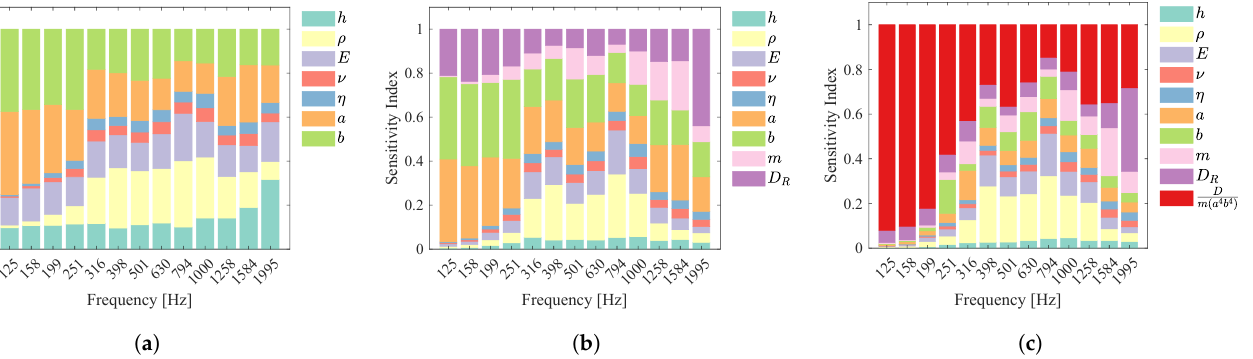
Figure 11. MDI-based sensitivity of the 1/3 octave band average STL of finite plate evaluated by FEM: ( a ) the inputs of the surrogate only consist of the STL variables ( RMSE = 2.23 ± 0.02 dB); ( b ) physics- guided features m and D R are included as input for the surrogate ( RMSE = 2.09 ± 0.02 dB); ( c ) physics-guided features m , D R and R are included as input for the surrogate ( RMSE = 1.63 ± 0.03